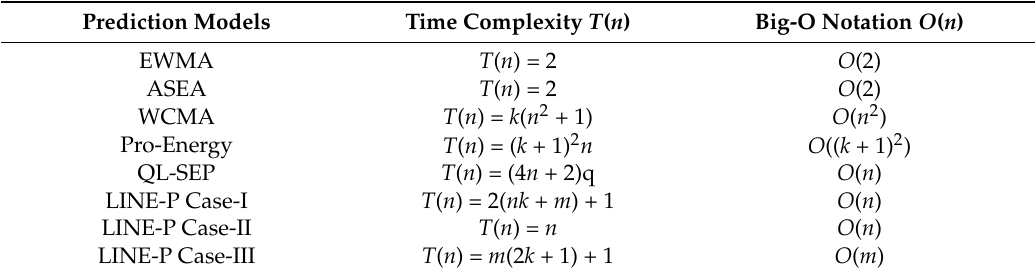
Table 4. Time Complexity of the LINE-P (all cases) and the other prediction models. Note: In some models, we consider m and k times rather than n